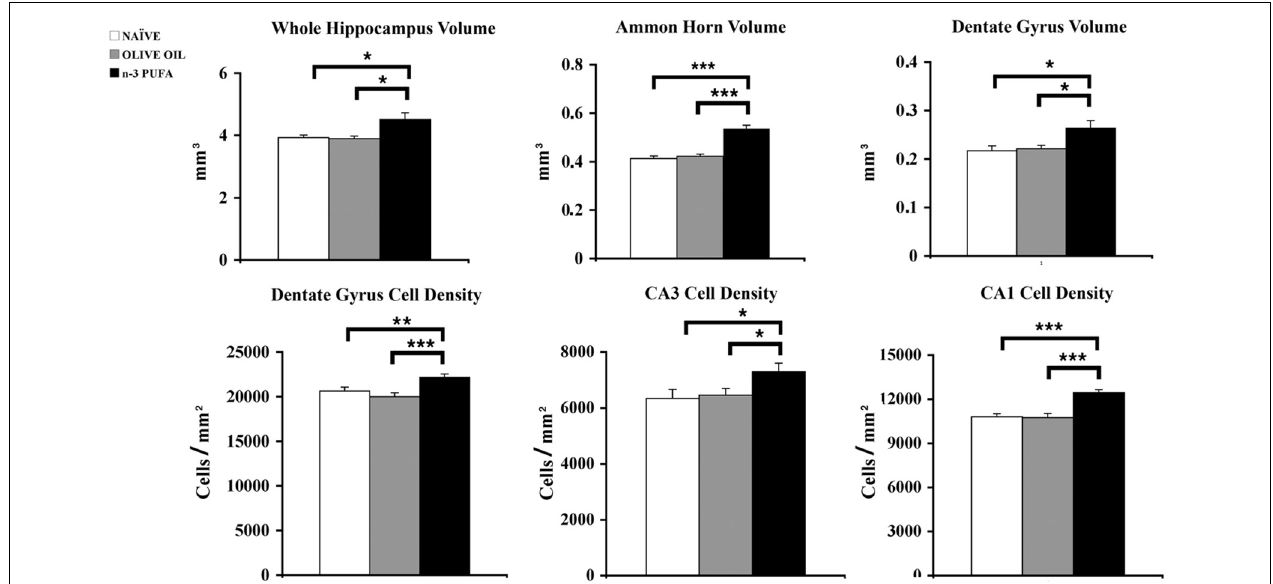
FIGURE 3 | n-3 PUFA effects on hippocampal volumes and cell density. Volumes of whole hippocampus, Ammon Horn (CA1 + CA3) and Dentate Gyrus resulted significantly enhanced in n-3 PUFA group in comparison to